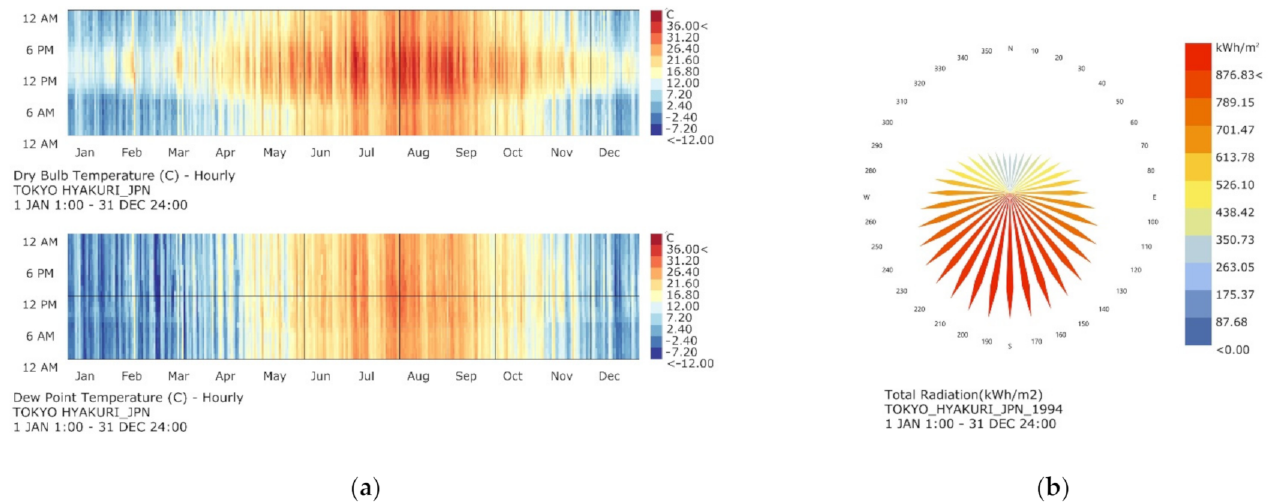
Figure 6. Tokyo climate variables: ( a ) Tokyo dry bulb and dew point temperature; ( b ) Tokyo total radiation of whole year.